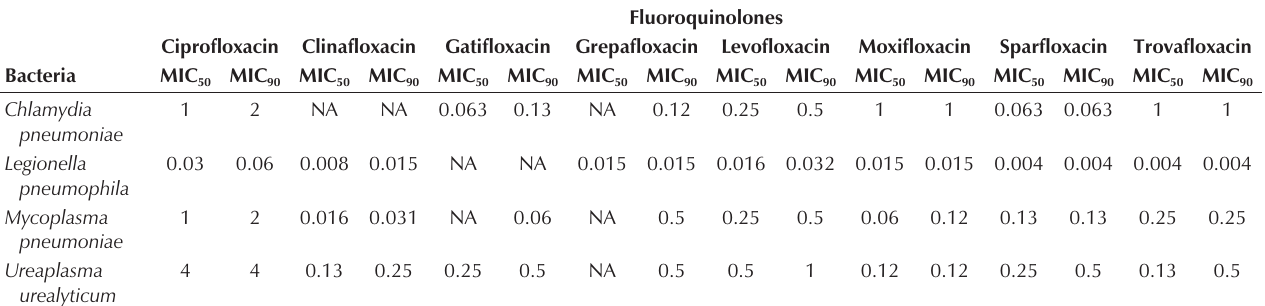
In vitro activity of the new fluoroquinolones and ciprofloxacin against other clinically important